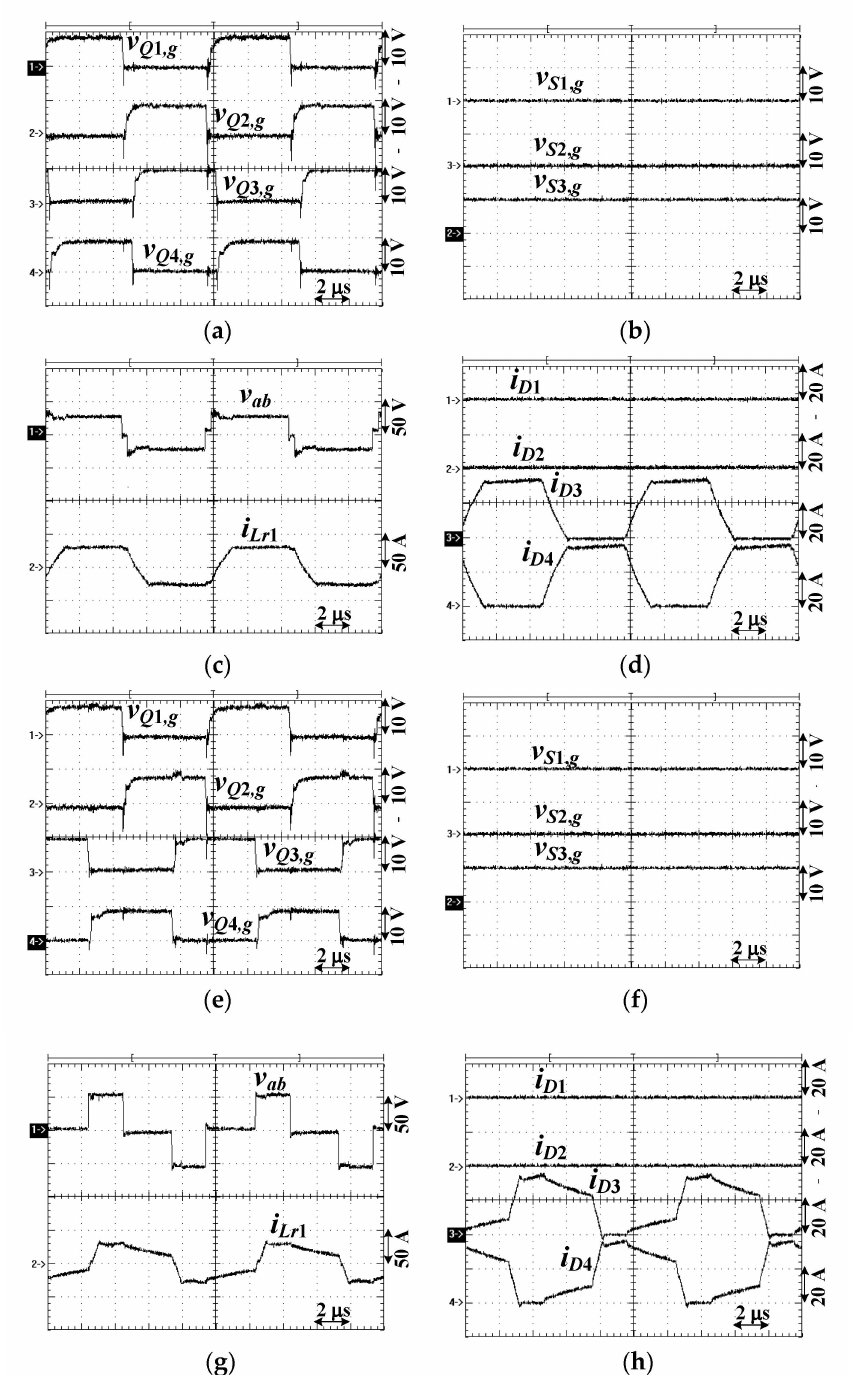
Figure 7. Measured results under the low voltage range and full load: ( a ) switch waveforms v Q 1 ,g ~ v Q 4 ,g at V in = 30 V, ( b ) AC switch waveforms v S 1 ,g ~ v S 3 ,g at V in = 30 V, ( c ) v ab and i Lr 1 at V in = 30 V, ( d ) i D 1 ~ i D 4 at V in = 30 V, ( e ) switch waveforms v Q 1 ,g ~ v Q 4 ,g at V in = 63 V, ( f ) AC switch waveforms v S 1 ,g ~ v S 3 ,g at V in = 63 V, ( g ) v ab and i Lr 1 at V in = 63 V, and ( h ) i D 1 ~ i D 4 at V in = 63